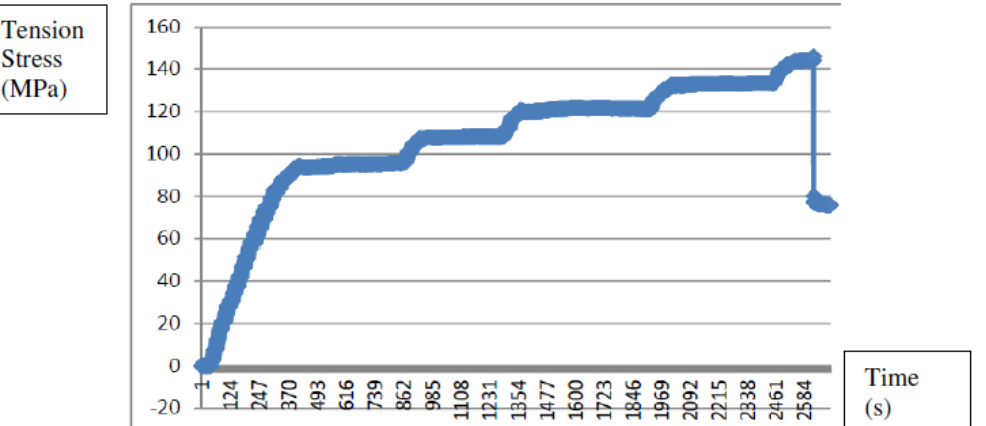
Fig. 7 Record from the strain gauge on the bottom surface under the load introduction point.